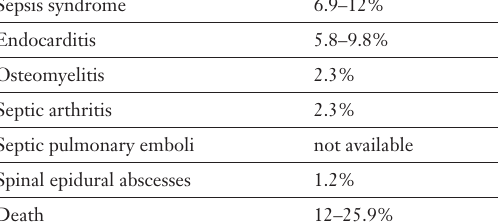
Incidence of compli- cations of HD catheter-related blood stream infec- tions [1, 4–8, 10, 15, 22, 28, 30, 32–39, 41, 71, 72].